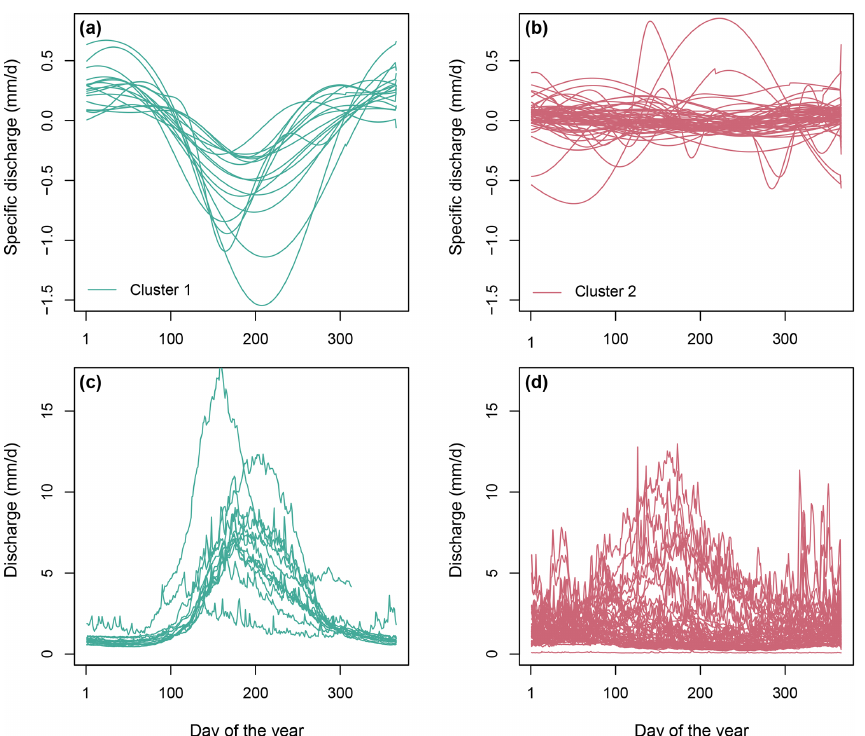
Figure 8. Reservoir regulation seasonality patterns clustered into two groups, namely (a) release in winter and storage in summer and (b) weak seasonal storage pattern. Natural streamflow regimes (computed using the undisturbed streamflow time series before reservoir construction) belonging to the two reservoir regulation clusters (c, d)